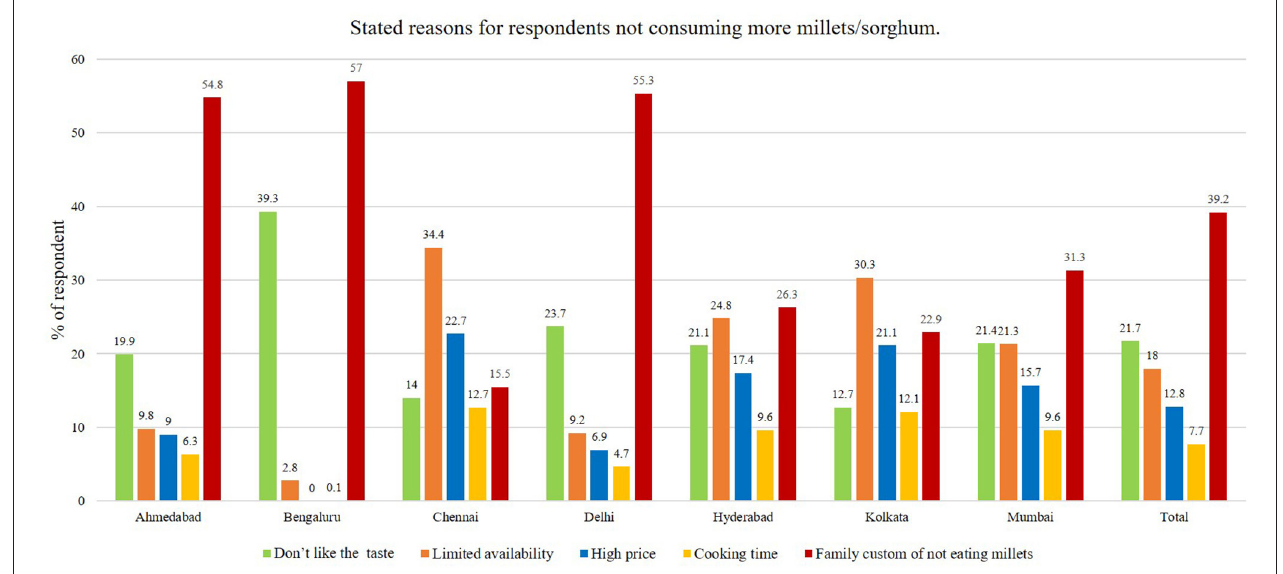
FIGURE 5 | Stated reasons for respondents not consuming more millets/sorghum.